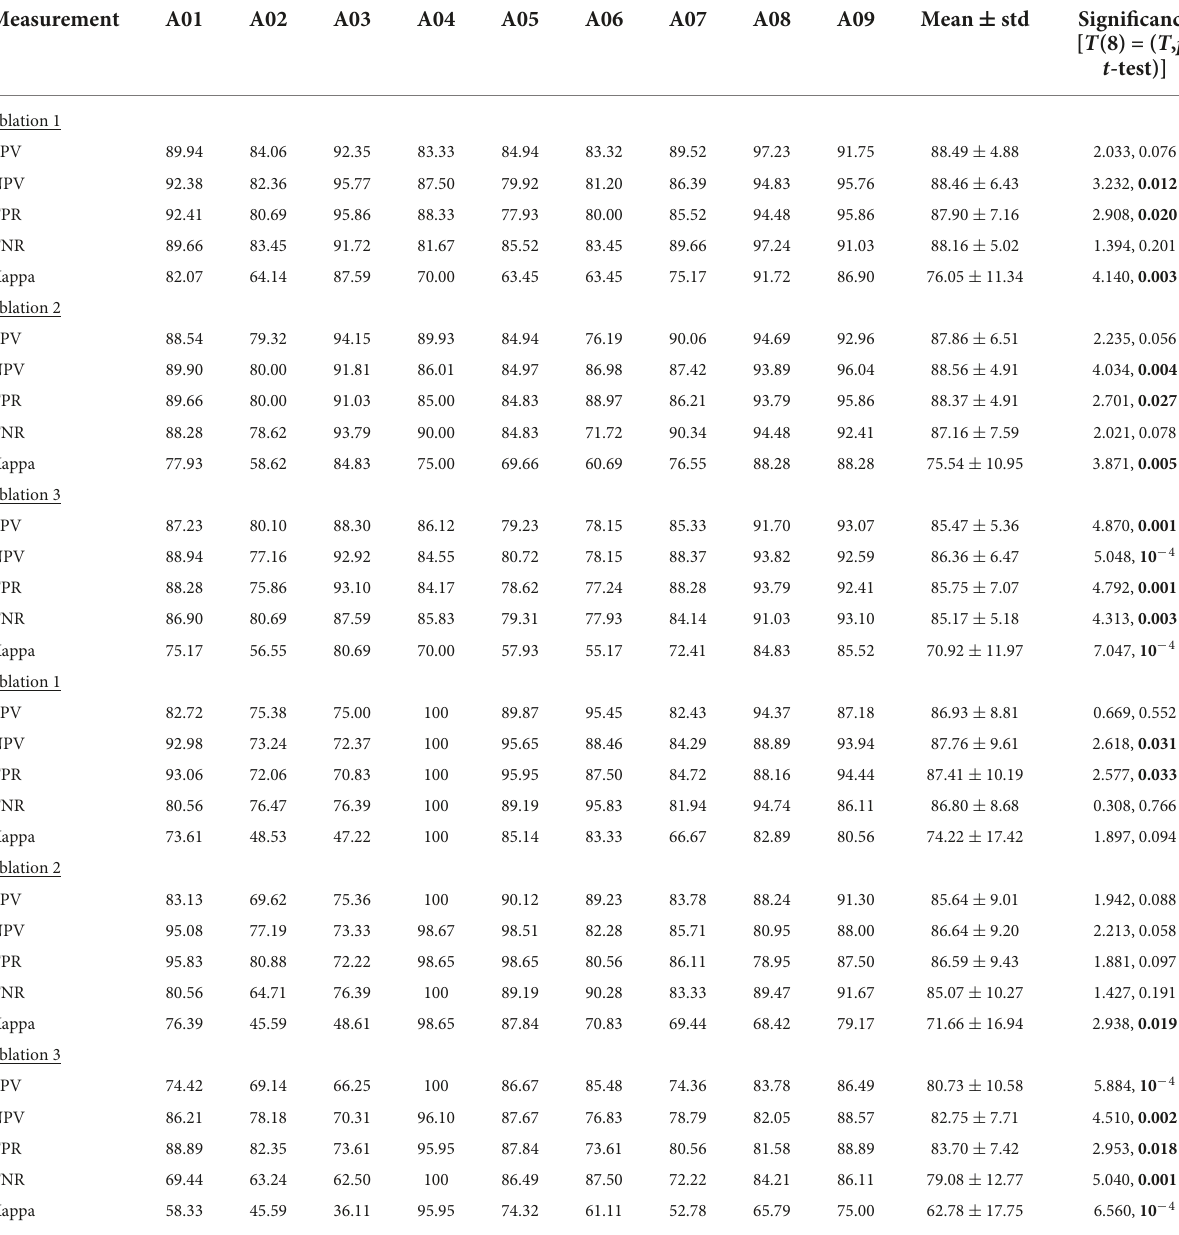
TABLE 9 Details of three ablation tests using our algorithm in dataset 1 and